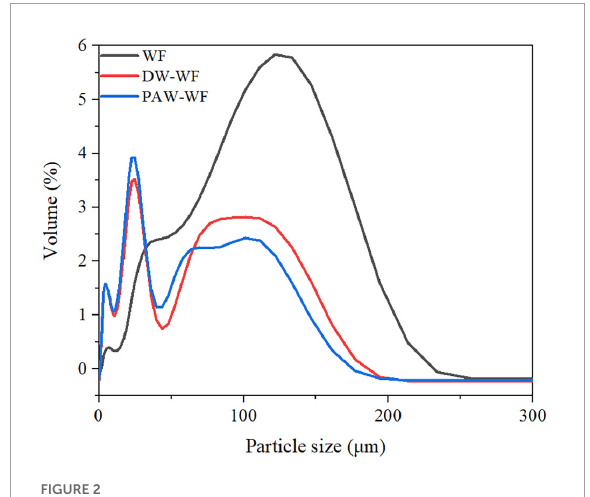
FIGURE2 Particle size distribution of WF and modified